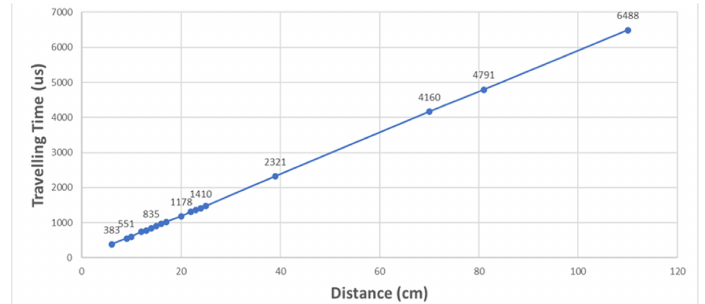
Fig. 8 Ultrasonic distance Vs Travelling time of sound wave